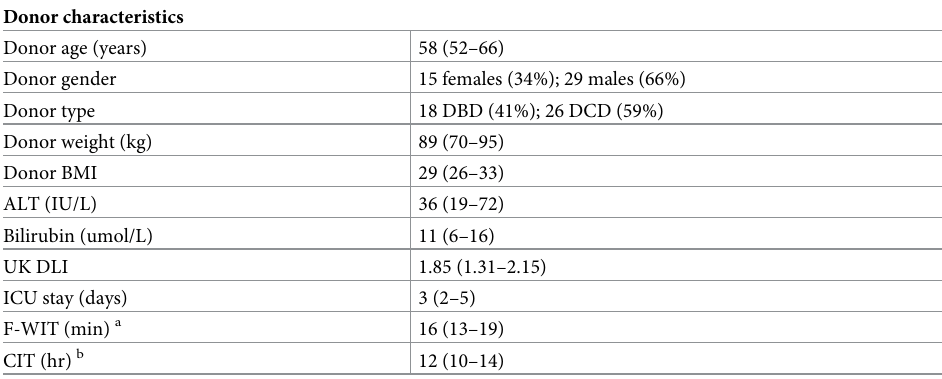
Table 1. Characteristics of donor liver grafts (n = 44).